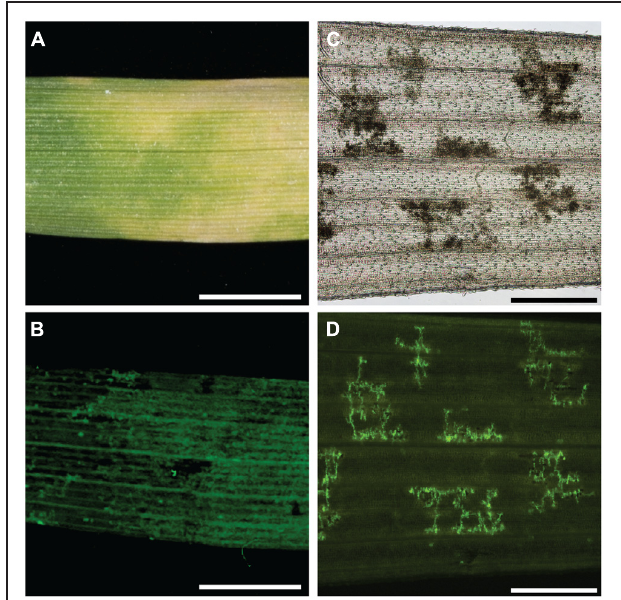
FIGURE 3 | Colocalization of chlorosis in barley and leaf browning in B. distachyon with P. striiformis f. sp. tritici hyphae. (A) Macroscopic chlorosis in barley accession Steptoe challenged with P . striiformis f. sp. tritici isolate 08/21. (B) Fluorescent micrograph of (A) stained with WGA-FITC. (C) Micrograph of a cleared leaf of B. distachyon accession Bd21 leaf exhibiting the leaf browning phenotype. (D) Fluorescent micrograph of (C) stained with WGA-FITC. The scale bar is 5 mm for (A,B) and 500 μ m for (C,D) .